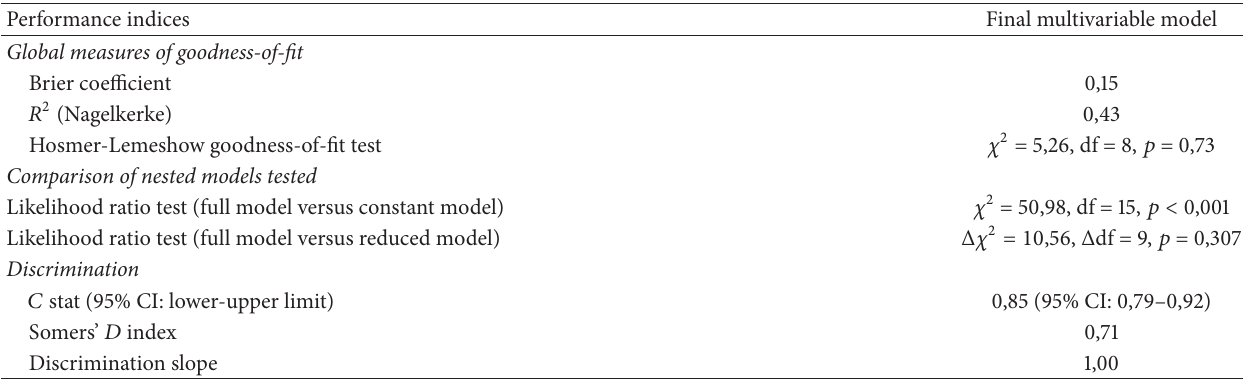
Table 4: Assessment of model